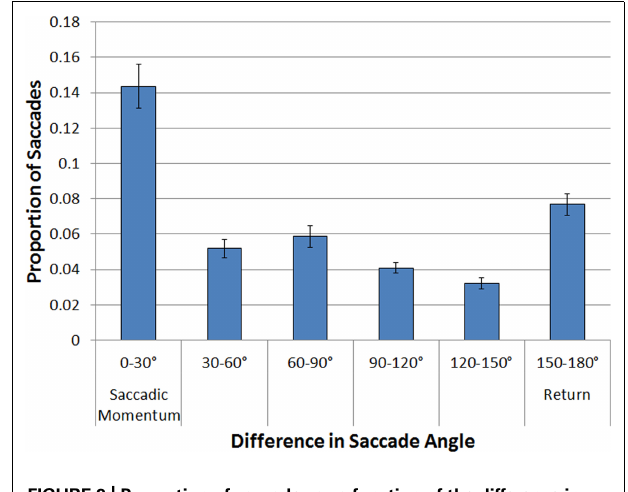
FIGURE 3 | Proportion of saccades as a function of the difference in angle between the current and the previous saccade, holding amplitude from previous to current saccade